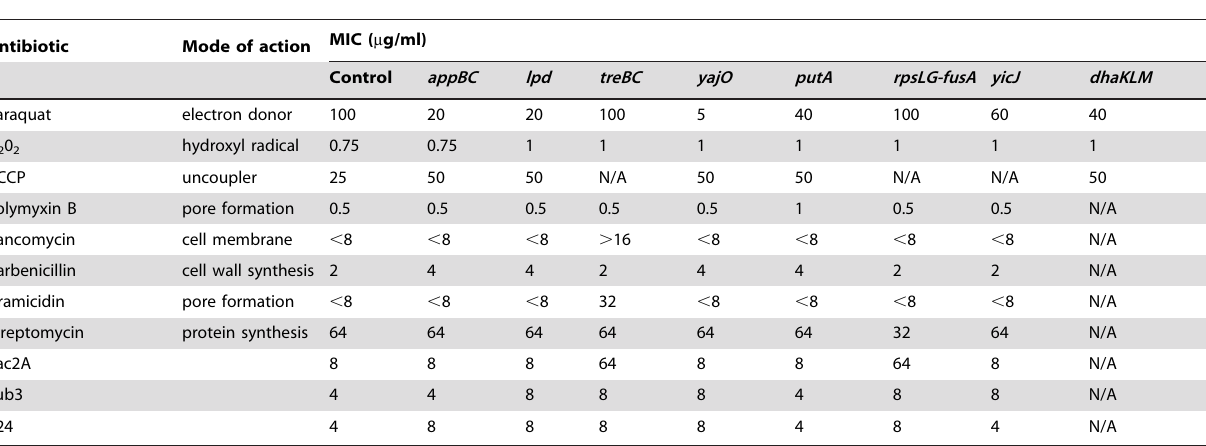
Table 1. The MIC for each compound was determined after 18 h incubation at 37 u C.